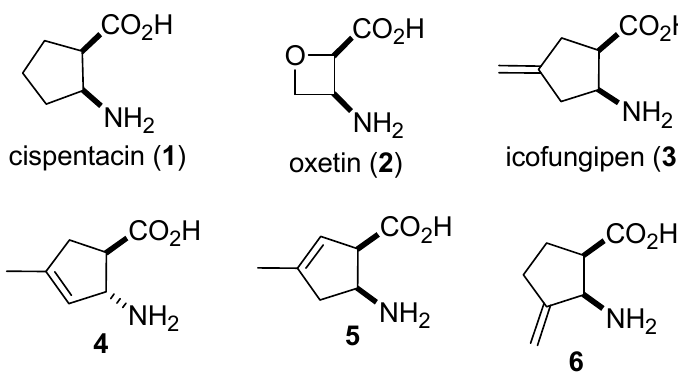
Figure 1. Some biologically interesting cyclic β -amino acids.